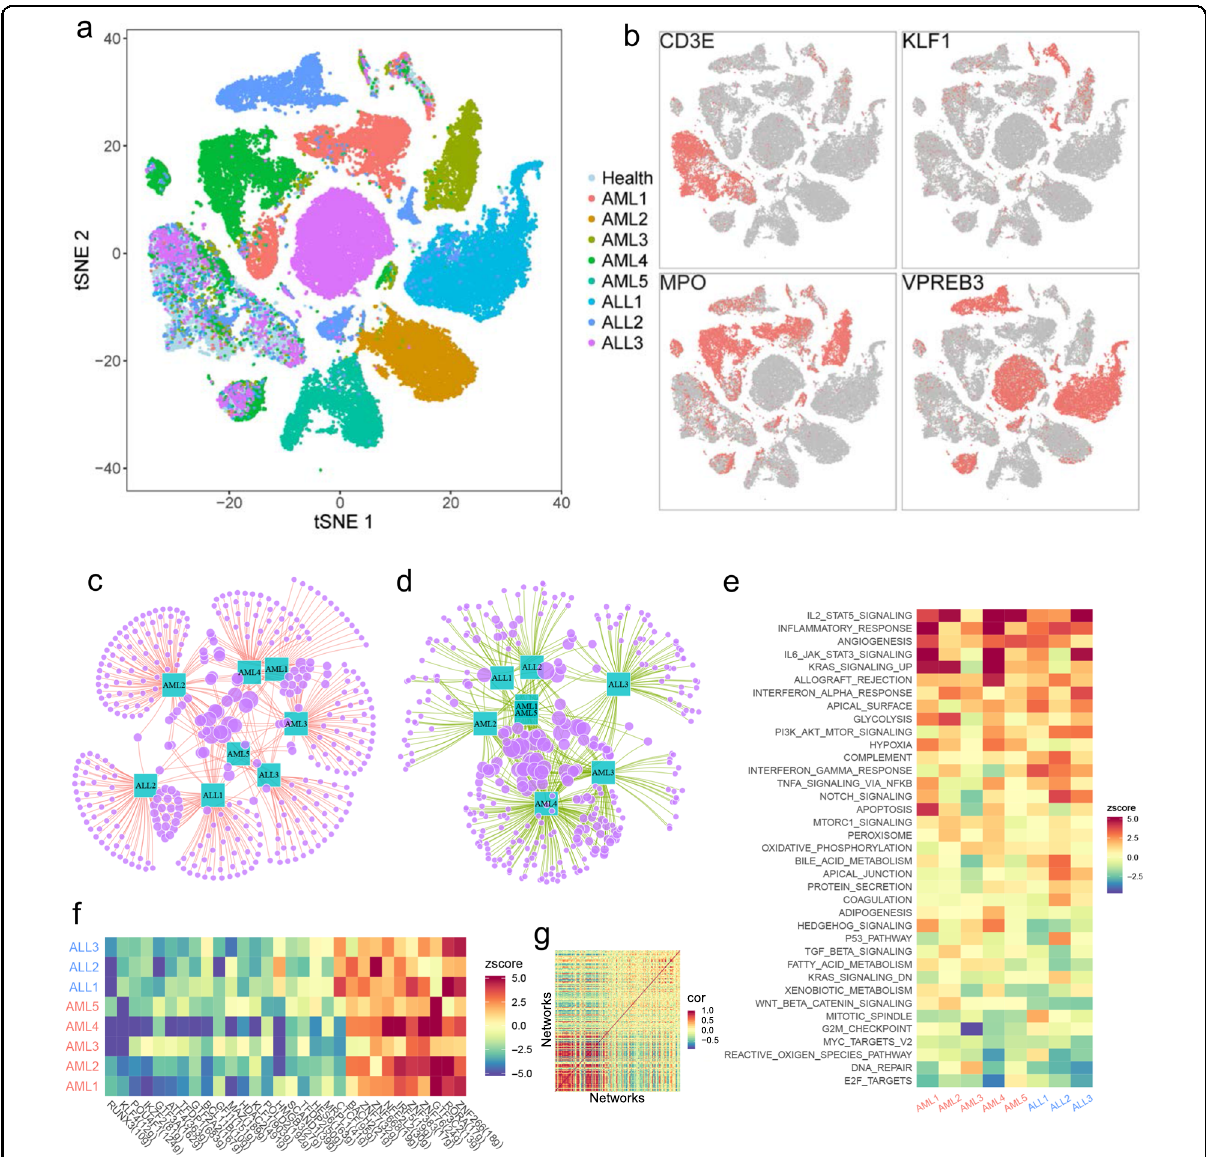
Fig. 3 Heterogeneity of leukemia cells and shared features among multiple patients. a tSNE projection of BMMCs from 1 healthy individual and 8 leukemia patients, colored by different individuals. b tSNE projection of BMMCs from leukemia patients, with each cell colored based on its expression of CD3E, KLF1, MPO, VPREB3, respectively. c Majority of upregulated genes among leukemia patients are patient speci fi c. d Majority of downregulated genes among leukemia patients are patient speci fi c. e Pathway or gene sets commonly upregulated and downregulated among leukemia patients. Z -score > 0 means upregulation of pathways while Z-score < 0 means downregulation. f Shared upregulated and downregulated TF networks among leukemia patients. Z -score > 0 means upregulation of TF networks while Z -score < 0 means downregulation. g Correlation of TF networks in leukemia patients, in which TF networks were sorted based on their enrichment score